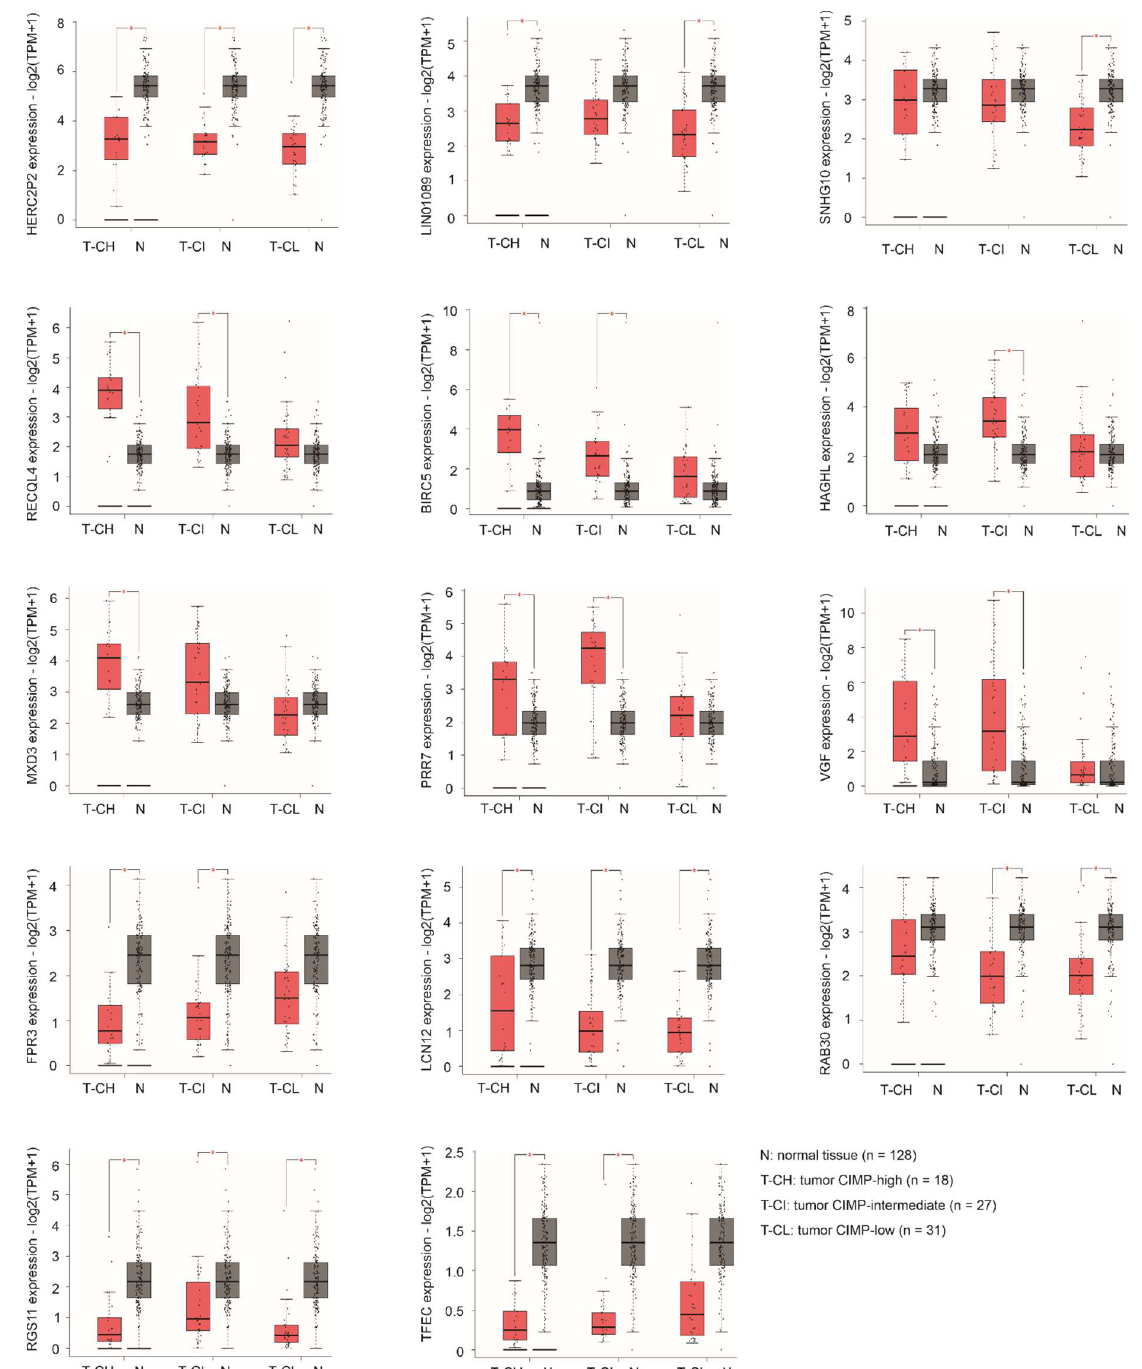
Figure 6. Differential expression of signature component genes. Gene expression was determined using RNA-seq data within the TCGA database organized by the GEPIA2 website [28]. * p < 0.05. Additionally, high levels of RECQL4, MXD3, and PRR7 mRNA expression are asso- ciated with advanced tumor stages (Figure 7A). Significant elevations of PRR7 mRNA ex- pression correlate with lymph node metastasis (Figure 7B). Intriguingly, elevations of RECQL4, MXD3, BIRC5, and SNHG10 expression are associated with TP53 mutations (Figure 7C). Considering TP53 mutations as a major genomic alteration in ACC [76,77], these genes likely cooperate with TP53 mutations to facilitate ACC tumorigenesis. These